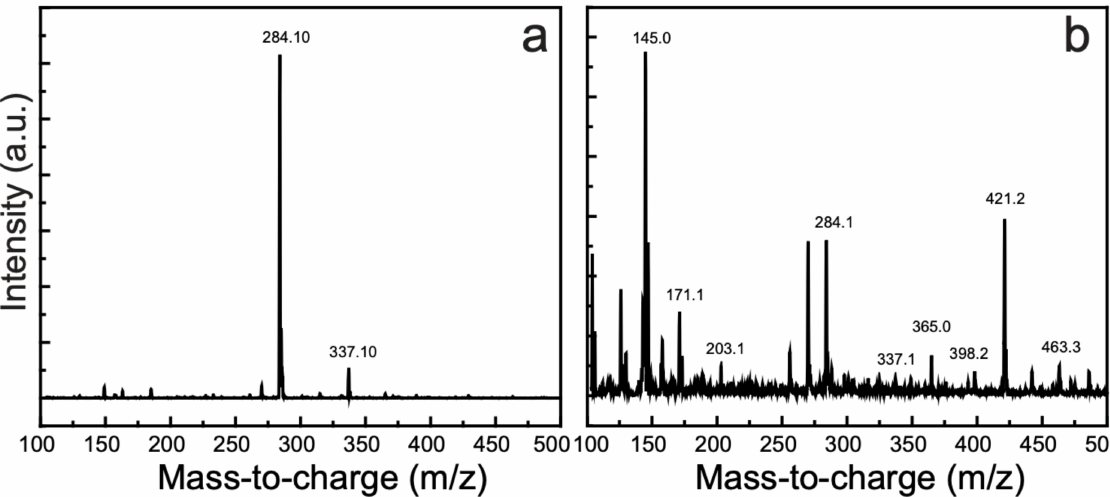
Figure 8. Mass spectra of an MB solution ( a ) before and ( b ) after the solution was subjected to photocatalytic action of CuOSC-3 for 2 h under solar-light irradiation. The full-scan spectra were recorded using a universal detector (+ESI scan (0.3 min), frag = 90.0 V, MB